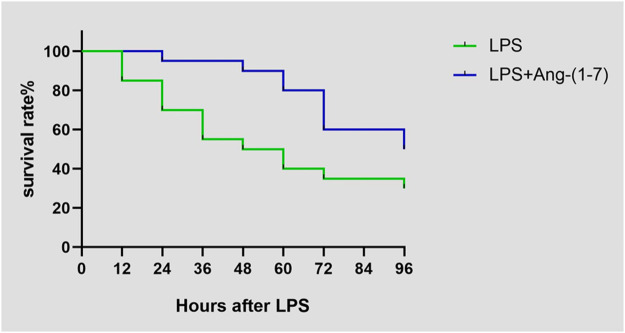
Effect of Ang-(1–7) on animal survival after LPS treatment. Animal survival was recorded at indicated time points.